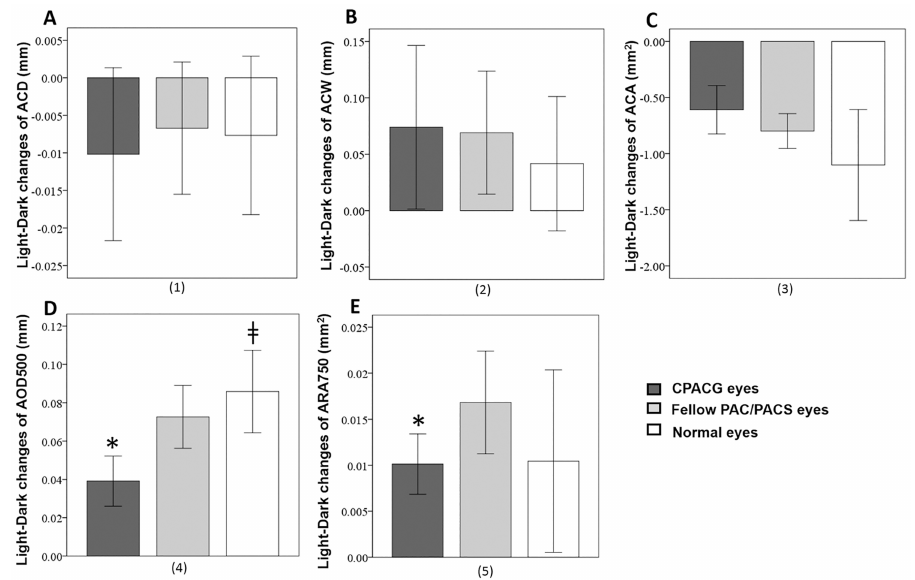
Fig 3. Light-to-dark changes of anterior chamber parameters in CPACG eyes, fellow PAC/PACS eyes, and normal eyes. A: There was no difference in light-to-dark changesof ACDs among the three groups. B: There was no difference in light-to-dark changesof ACWs amongthe three groups. C: There was no difference in light-to-dark changesof ACAs among the three groups. D: The light-to-dark changesof AOD500 μ m in CPACG eyes were smaller than those in their fellow PACS/PAC eyes and normal eyes. There was no difference in the light-to-dark changesof AOD500 μ m betweenPACS/PAC eyes and normal eyes. E: The light-to-darkchangesof ARA750 μ min CPACG eyes were smaller than those in their fellow PACS/PAC eyes. There was no difference in the light-to-dark changesof ARA750 μ m betweenPACS/PAC eyes and normaleyes. CPACG: chronicprimary angle closure glaucoma;PAC: primary angle closure; PACS: primary angle closuresuspect; ACA: anterior chamberarea; AOD500 μ m: angle openingdistance500 μ m from the scleral spur; ARA750 μ m: angle recess area 750 μ m from the scleral spur; ACD: anterior chamber depth; ACW: anterior chamberwidth; * : significantdifference betweenPACG eyes and fellow eyes ( P < 0.017); ‡: significantdifference betweenPACG eyes and normal eyes ( P < 0.017); Error bars: 95% confidenceinterval (95% CI).